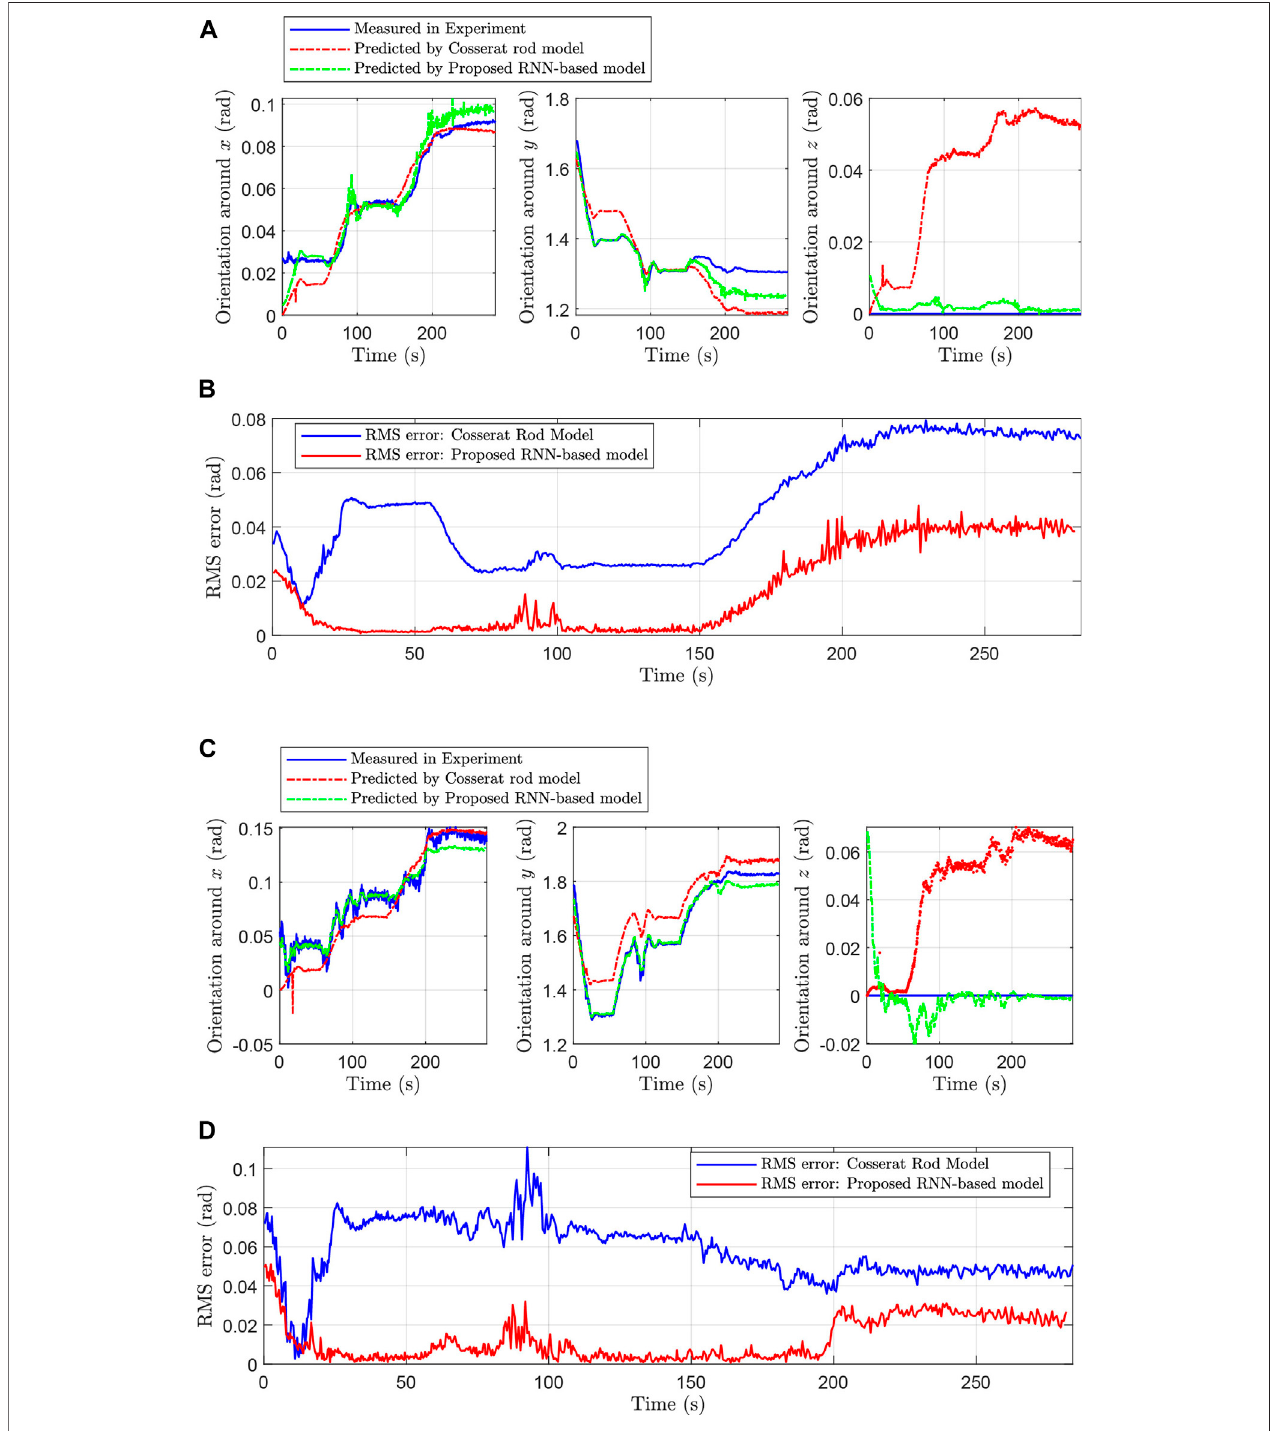
FIGURE 12 | (A) : Measured and predicted orientations of tip/distal magnet by Cosserat rod model and proposed RNN-based model. (B) : RMS error for distal/tip magnet resulted from Cosserat rod model and proposed RNN-based model. (C) : Measured and predicted orientations of middle/proximal magnet by Cosserat rod model and proposed RNN-based model. (D) : RMS error for middle/proximal magnet resulted from Cosserat rod model and proposed RNN-based model.